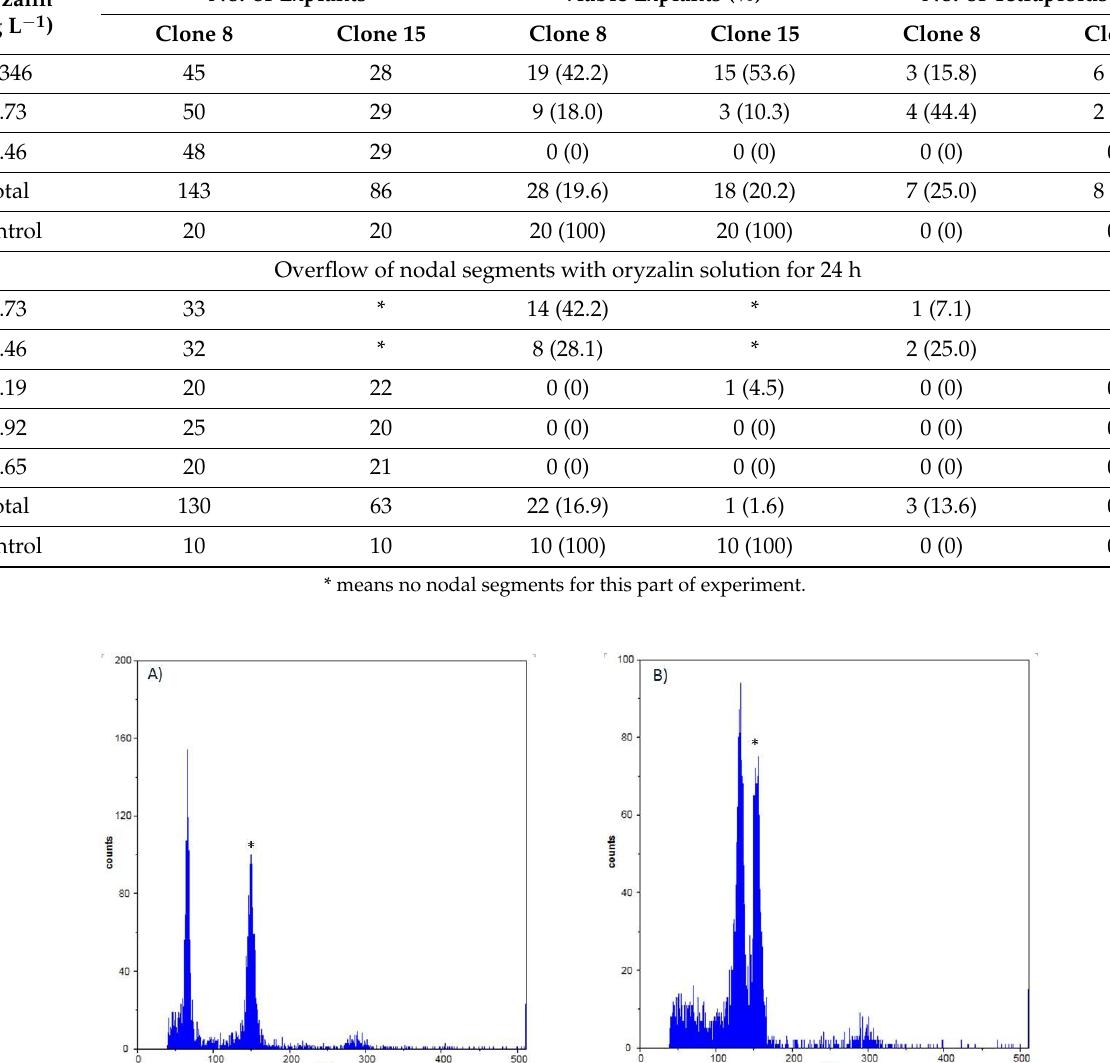
Figure 1. Representative flow cytometric histograms of nuclear DNA contents of T. vulgaris . ( A ) diploid reference plant and internal standard Zea mays * and ( B ) tetraploid originated from clone No. 8 and standard Zea mays *.